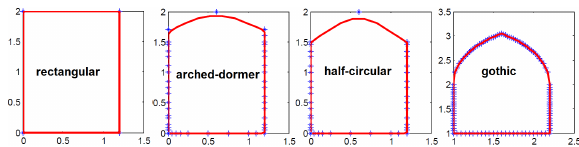
Figure 4: The span of windows and doors templates, Q 0 , used during this work. This ranges from the simple rectangular rep- resented by the four corner points (marked blue) through the arched-dormer, half-circular and gothic windows and doors rep- resented by many more control points.